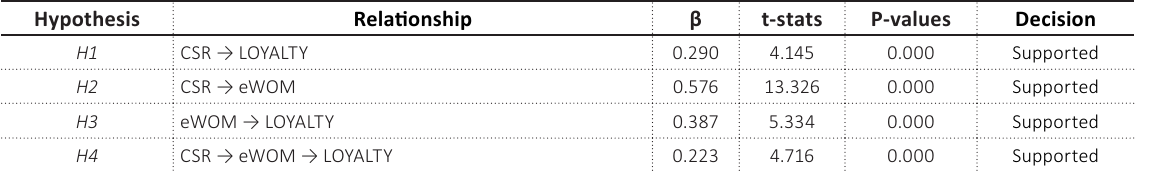
Table 4. The results of the hypothesis